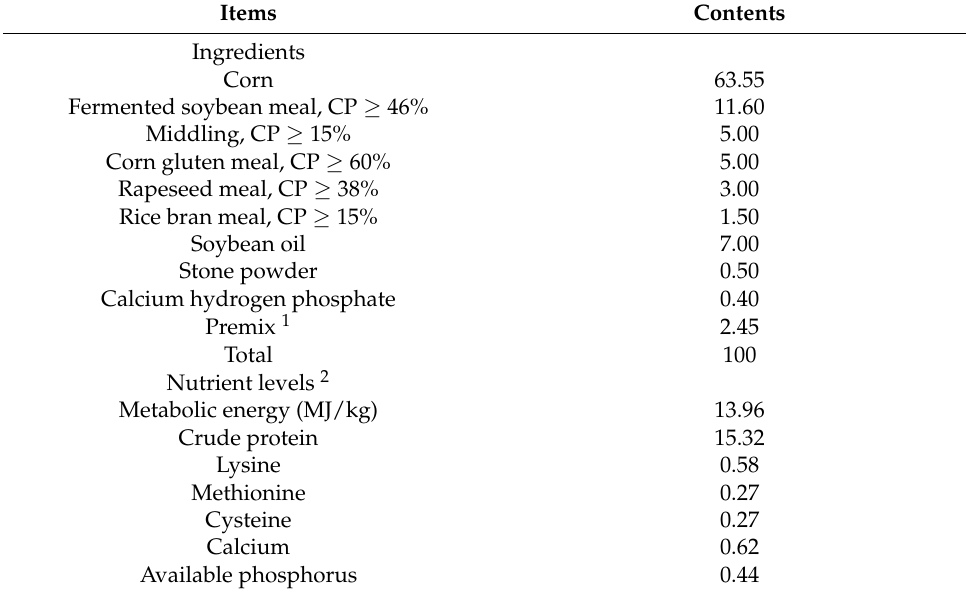
Table 1. Ingredient and nutrient levels of basal diet (%,